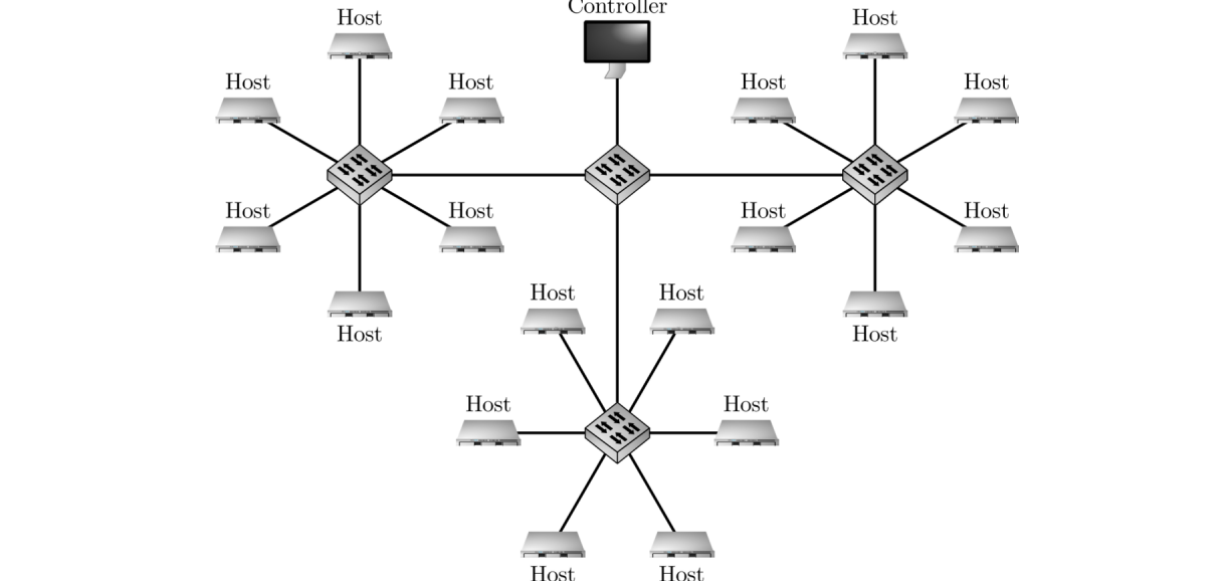
Figure 1. Topology of the testbed